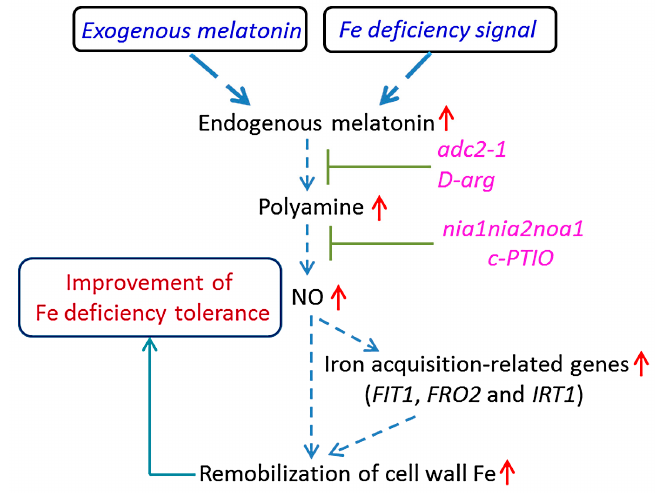
Figure 11. A proposed model illustrating the link between melatonin and improved tolerance of plants to Fe deficiency. The increased melatonin level induces the increment of the polyamine content, with the subsequent induction of NO accumulation. The enhancement of the NO signal then activates Fe deficiency responses and increases the remobilization cell wall Fe, which results in the increased soluble Fe in response to the low Fe supply. Dashed arrows indicate regulatory pathways. Red upright arrows denote increases in content or effects.